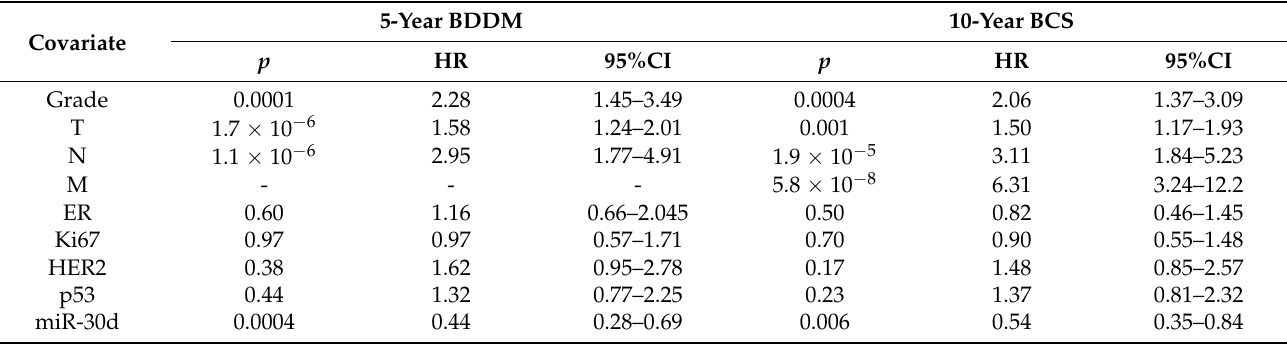
Table 2. High expression of miR-30d emerged as independent prognostic factor in the multivariate Cox regression model for 5-year BDDM, and 10-year BCS